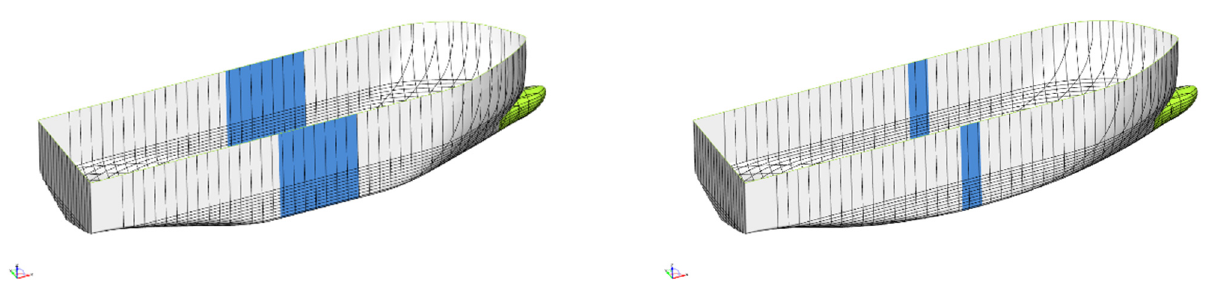
Figure 8. Digital Siblings: Two hull forms with lengthened and shortened parallel mid-body (shown in blue), but with identical displacement and longitudinal centers of buoyancy [18].